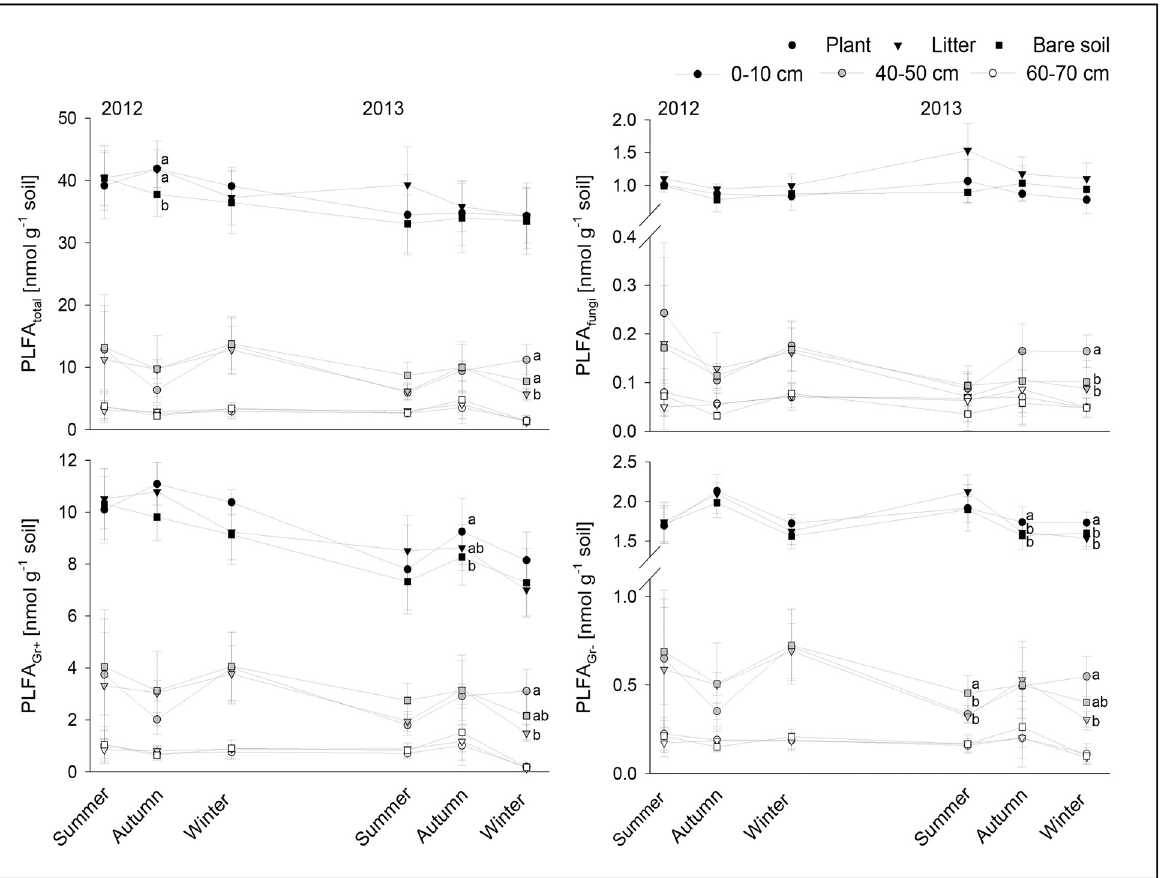
Fig 1. Biomass of microbial groups determined as soil phospholipid fatty acids (PLFAs in nmol g -1 dry weight soil ± SD) in soil cropped with maize (plant), amended with maize shoot litter (litter) or bare soil, in topsoil (0–10 cm), rooted zone (30–40cm), and root free zone (60–70cm) in the years2012 and 2013. Given is the biomass for total microbialassemblages (PLFA total ), Gram- positive bacteria (PLFA GR+ ), Gram-negative bacteria (PLFA GR- ) and fungi (PLFA fungi ). Values within a samplingdate with the same or no letters are not significantlydifferent accordingto Tukey´s HSD test at P < 0.05.